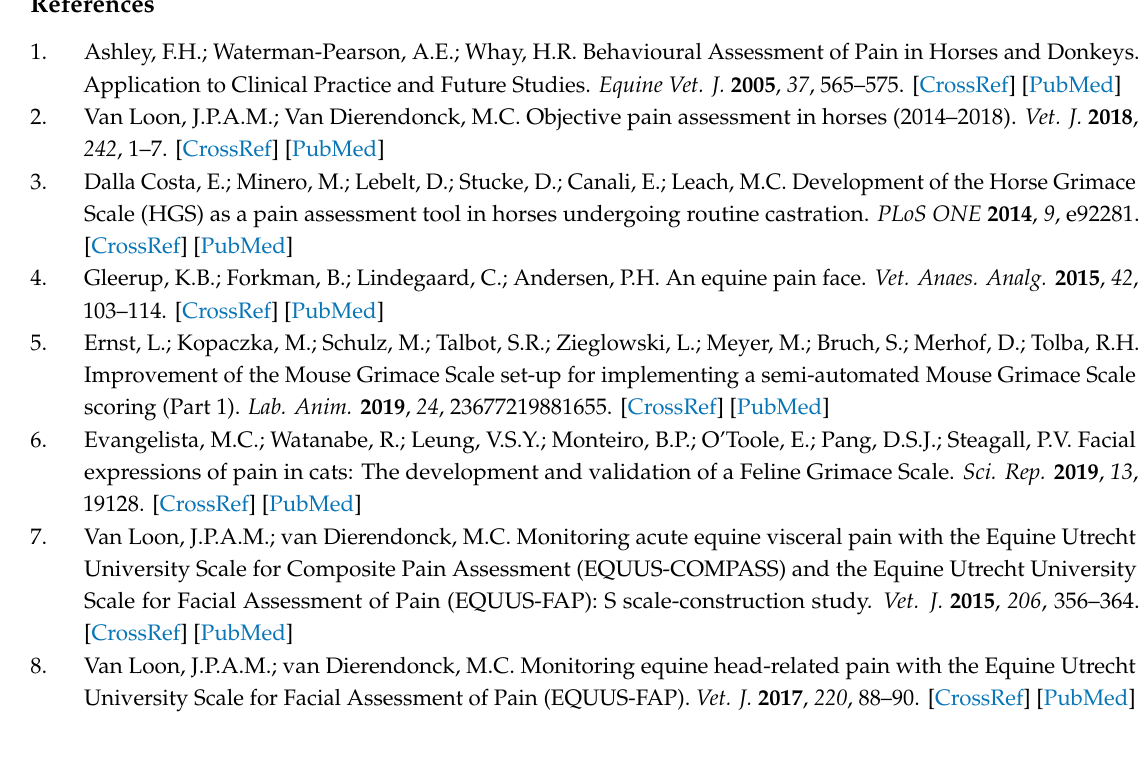
s1, Table S1: Details on patients and healthy control foals, Table S2: EQUUS-FAP FOAL scores of observer 1 for the neonatal foals, Table S3: EQUUS-FAP FOAL scores of observer 2 for the neonatal foals, Table S4: EQUUS-FAP FOAL scores of observer 3 for the neonatal foals, Table S5: EQUUS-FAP FOAL scores of observer 1 for the older foals, Table S6: EQUUS-FAP FOAL scores of observer 2 for the older foals, Table S7: EQUUS-FAP FOAL scores of observer 3 for the older